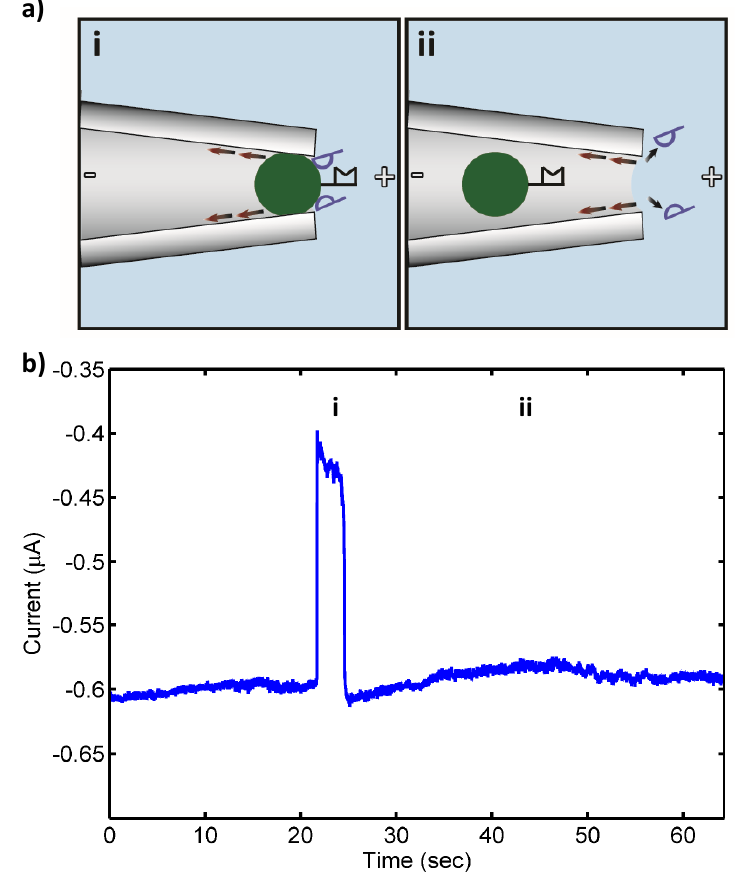
Figure 2. ( a ) Schematic of control (noncomplementary) Pseudomonas putida rRNA (blue, 10 pM) nonspecifically bound to bead-PNA probe conjugates under applied electric field in the drawn micropipette tip: (i) open pore state as bead with bound RNA approaches the micropipette tip (“pore”); (ii) transient blockade of the pore by the PNA-bead conjugate with nonspecifically bound noncomplementary RNA (blocked pore state); and (iii) relief of the pore blockade after the noncomplementary RNA of control bacteria was detached from the bead in the strong electric field at the micropipette tip and the bead is carried away from the pore by the opposing electroosmotic flow (red arrows) (open pore state). ( b ) Measured ionic current through the pore: (i) open pore current; (ii) current blockade by PNA-bead conjugates with bound RNA; and (iii) relief of the current blockade after the nonspecifically bound RNA was detached from the bead and the lack of tightly bound, complementary 16S rRNA resulted in the bead conjugate being swept from the pore by the opposing electroosmotic flow.